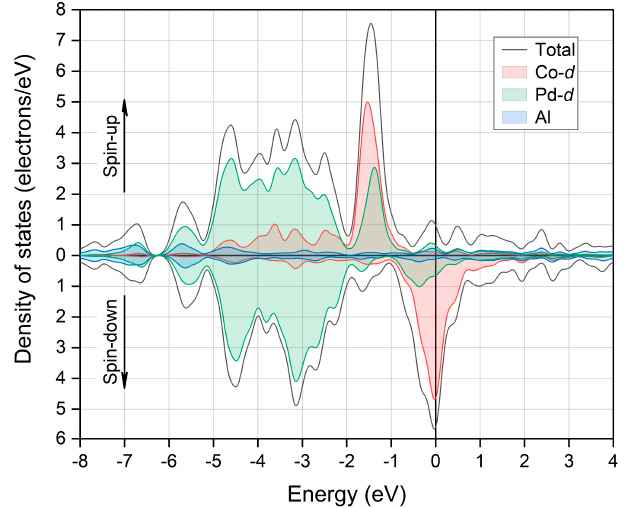
Figure 4. The calculated total and partial densities of states for the full Heusler compound Pd 2 CoAl in L2 1 -type cubic structure at the equilibrium lattice constant.